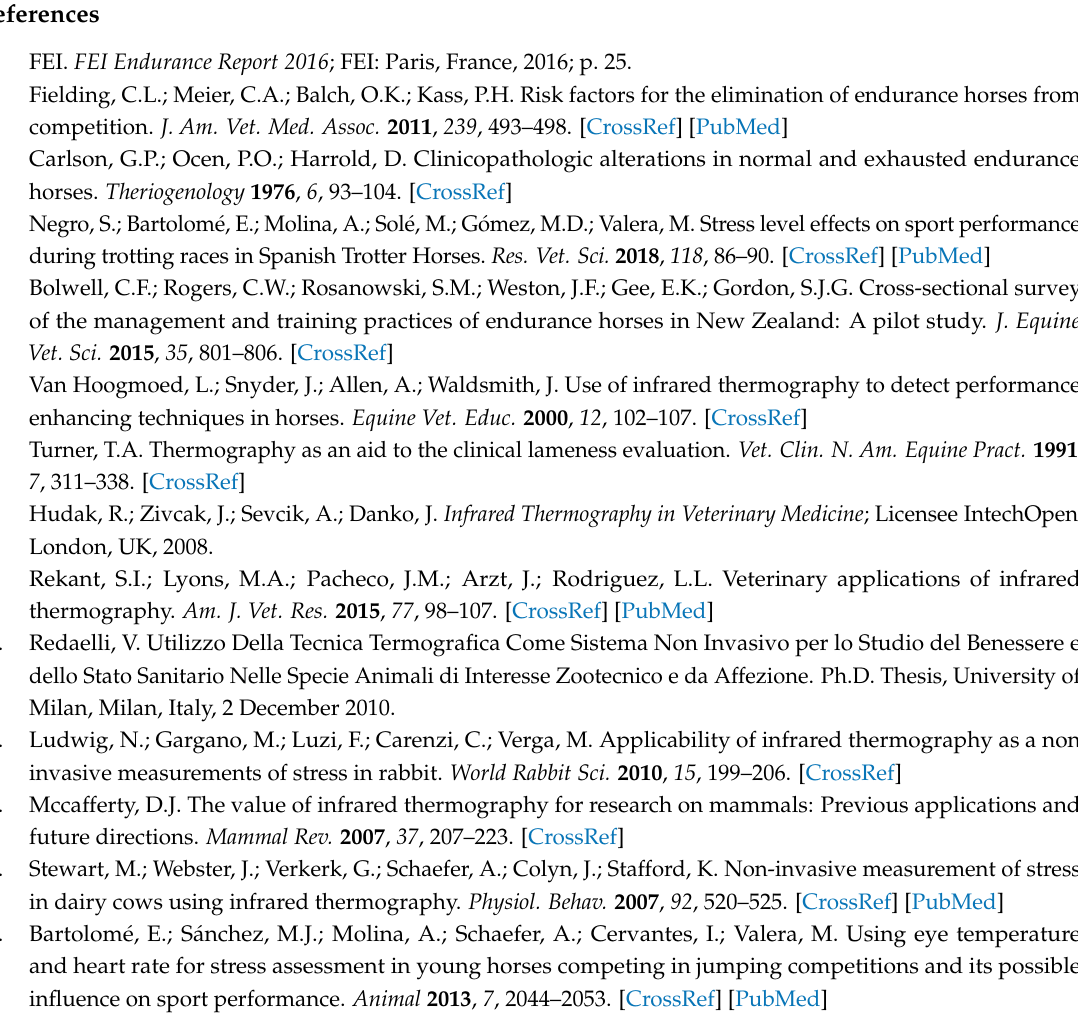
Figure S1: Photo of the walker/horse training machine from above, Figure S2: Heart rate (HR) variations within the same horse across the 3 bouts: low (1), moderate (2), and high (3) intensity, Figure S3: Front right crown temperature variations (expressed in ◦ C) within the same horse across the 3 bouts: low (1), moderate (2), and high (3) intensity, Figure S4: Front left crown temperature variations (expressed in ◦ C) within the same horse across the 3 bouts: low (1), moderate (2), and high (3) intensity, Figure S5: Front right pastern temperature variations (expressed in ◦ C) within the same horse across the 3 bouts: low (1), moderate (2), and high (3) intensity, Figure S6: Longissimus dorsi temperature variations (expressed in ◦ C) within the same horse across the 3 bouts: low (1), moderate (2), and high (3) intensity, Figure S7: White blood cell (WBC) variations (expressed in k/ µ l) within the same horse across the 3 bouts: low (1), moderate (2), and high (3) intensity, Table S1: Descriptive statistics of the studied parameters expressed by intensity, Table S2: Descriptive statistics of the studied parameters expressed by time, Table S3: Pearson correlations among the studied